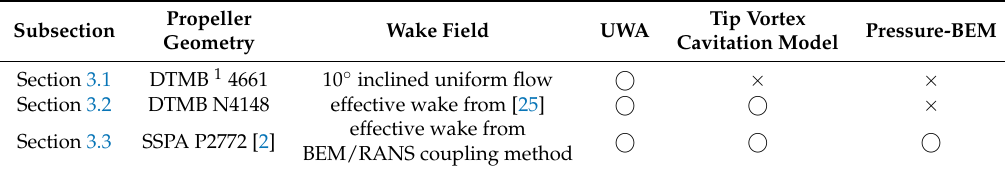
Table 1. Applications of the numerical models in Section 3.3.